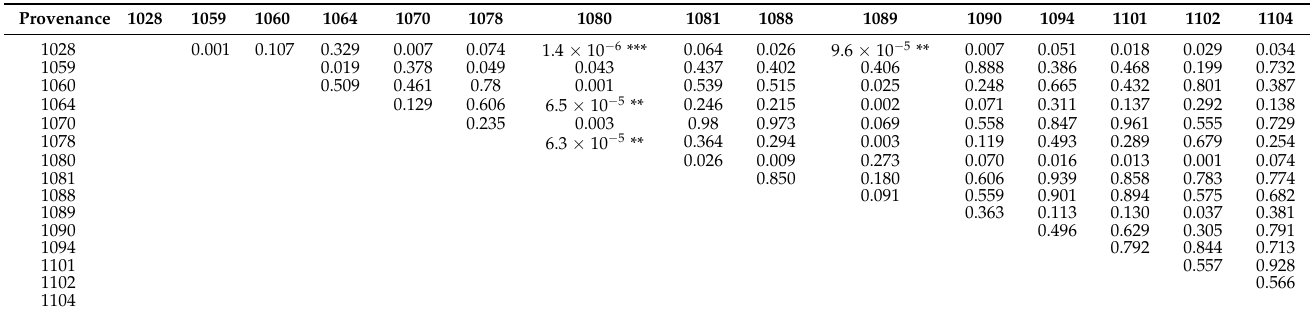
Table A1. Matrix of pair comparisons of provenances average dbh with the Mann–Whitney U-test ( p values). Significance levels are adjusted using sequential Bonferroni according to Rice (1989)49 (** 0.001 < p < 0.01; *** p < 0.001). See Table 1 for provenance